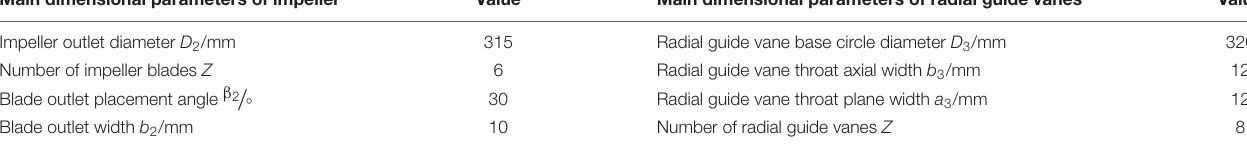
TABLE 1 | Dimensional parameters of impeller and radial guide vane. Main dimensional parameters of impeller